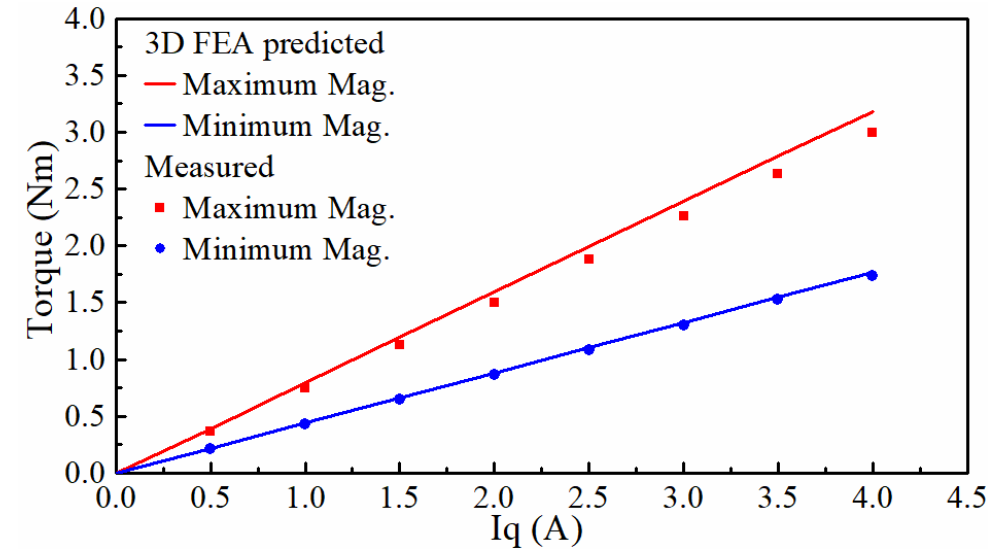
Figure 20. Average torque versus q-axis current in the maximum and minimum magnetization states. Finally, by continuously performing magnetization or demagnetization from different initial magnetization states, the resultant back-EMFs in different magnetization states were measured and are shown in Figure 22. The measured maximum flux regulation capacity was approximately 40%, which is 5% smaller than the predicted value. The results demonstrate that the hysteresis loops can be used to characterize the change of back-EMFs due to pulse currents and provide information about flux regulation due to the magnetization variation in SPM memory